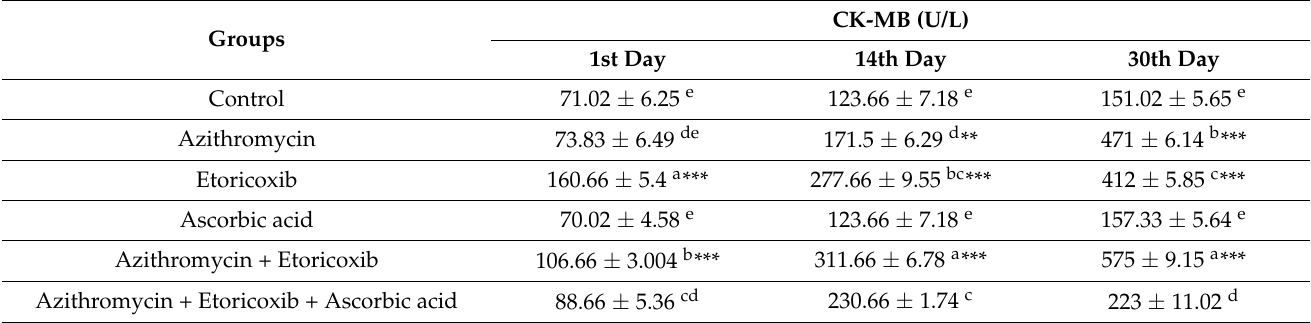
Table 5. Effects of ascorbic acid on heart function marker (CK-MB) in male rats after 30 days of administration of either azithromycin or etoricoxib or their combinations.